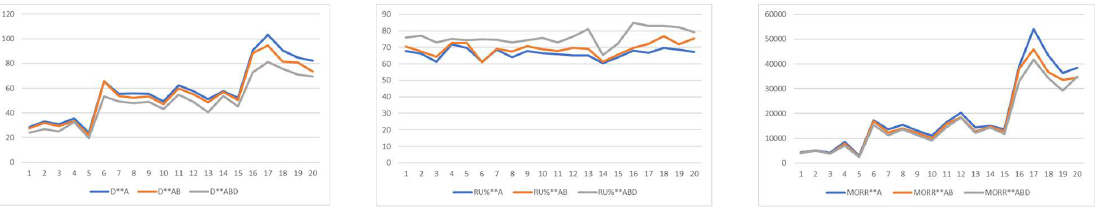
Fig. 5. Duration, resource utilization, and MORR. criterion in graphic